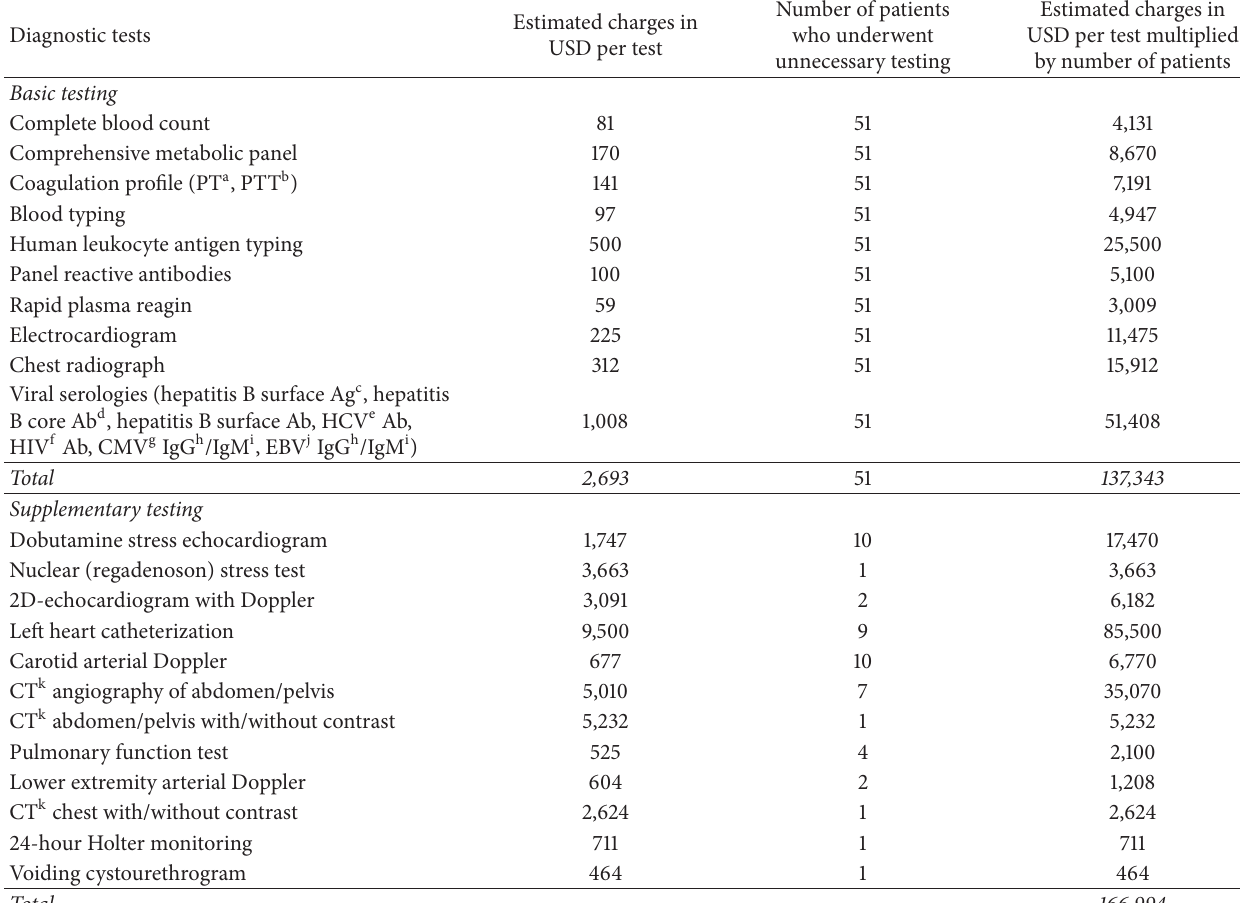
Table 1: Estimated charges of “basic” and “supplementary” diagnostic